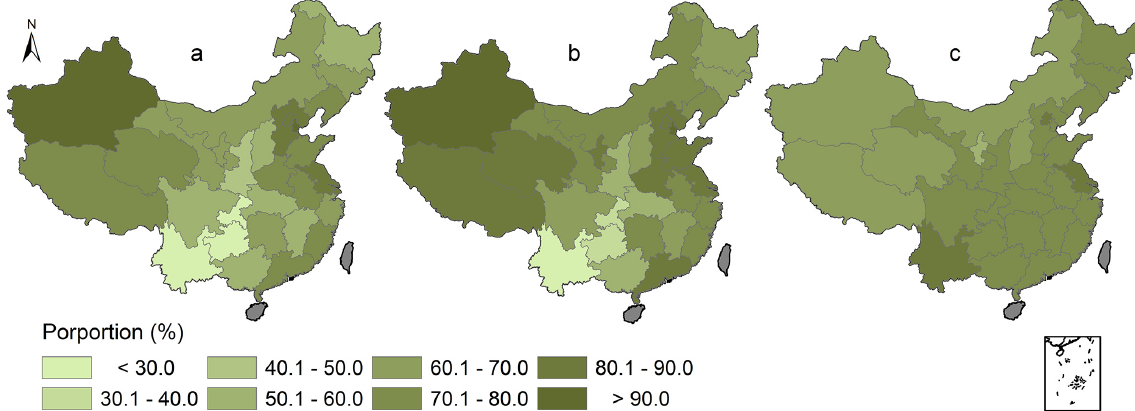
Figure 3. Proportions of water use in irrigated land in China, including (a) the proportion of the WF I in the WF, (b) the proportion of the TWU I in the TWU and (c) the proportion of the WF in the TWU for irrigated crops (WF I / TWU I